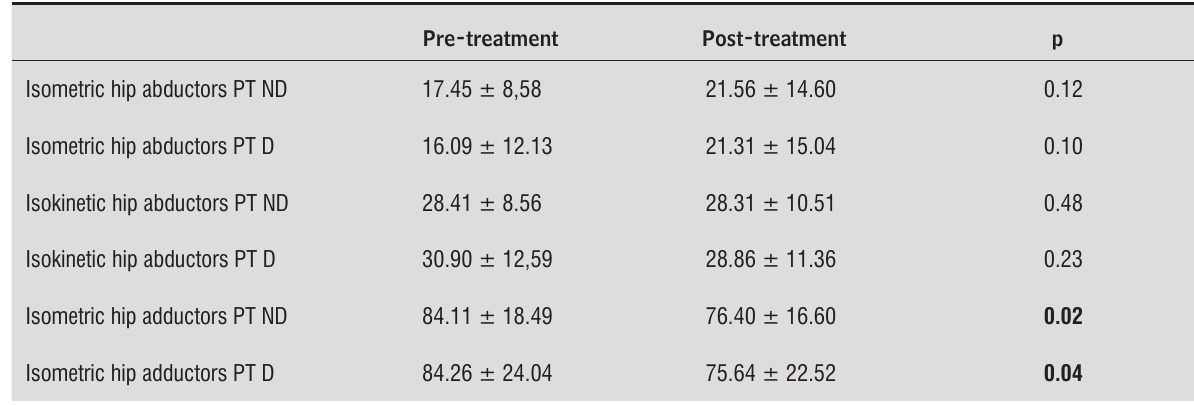
Table 2 - Isometric and isokinetic hip abductors and adductors peak